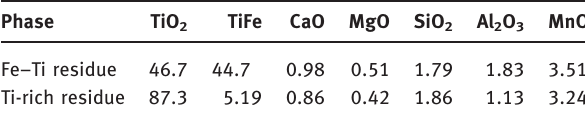
Table 1: Chemical composition of the original materials (wt%).